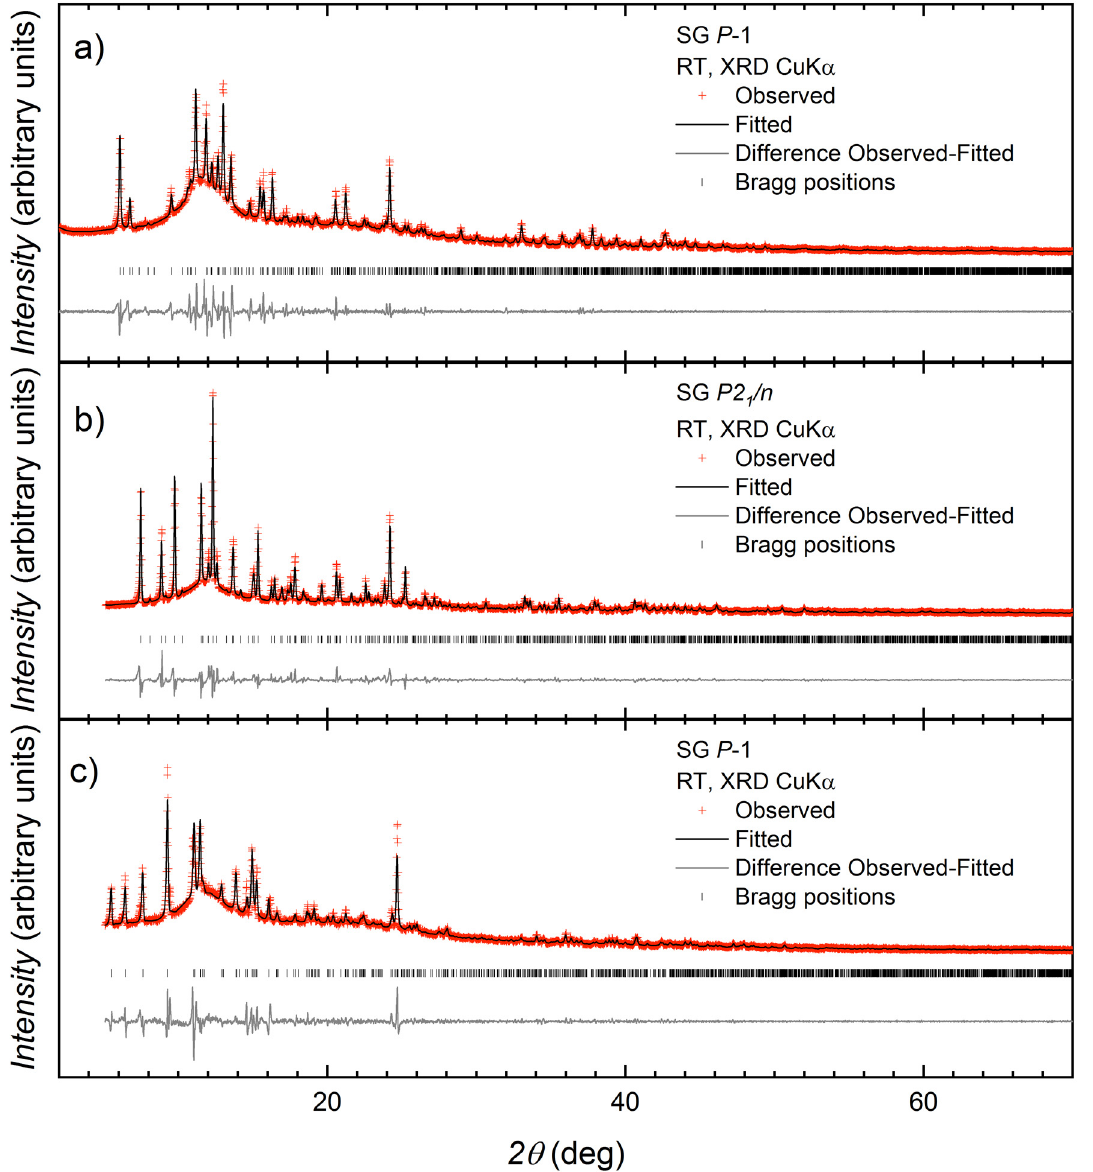
Figure 10. Laboratory X-ray diffraction (CuK α 1 radiation) pattern (red crosses) of ( a ) [2{Cu 2 ( µ -OAc) 4 ( 2 )} · 1.25MeOH] n , ( b ) [Cu 2 ( µ -OAc) 4 ( 3 )] n and (c) [{Cu 2 ( µ -OAc) 4 ( 4 )} · 0.2CHCl 3 ] n at room temperature. The black line corresponds to the best fit from the profile matching refinement. Lower vertical marks denote the Bragg peak positions. The bottom line in each plot represents the difference between experimental and calculated points.